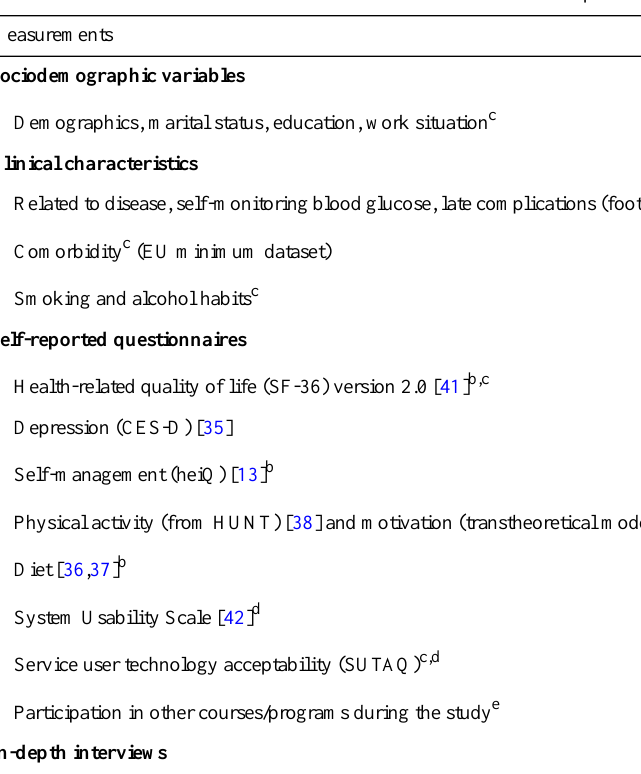
Table 1. Data collected at baseline and after 4- and 12-month follow-ups.